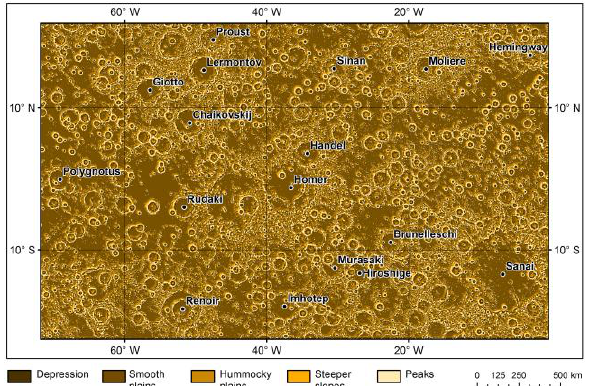
Figure 6. Morphological map of Kuiper quadrant; classified values of morphometric parameters clearly show small Sihtu plain and complex impact structures in the middle of rough inter-crater plains As an experiment, the ranges of values for the classes used for Mercury did not change at all and fully corresponded to numbers obtained after for the Moon. Despite this, types of